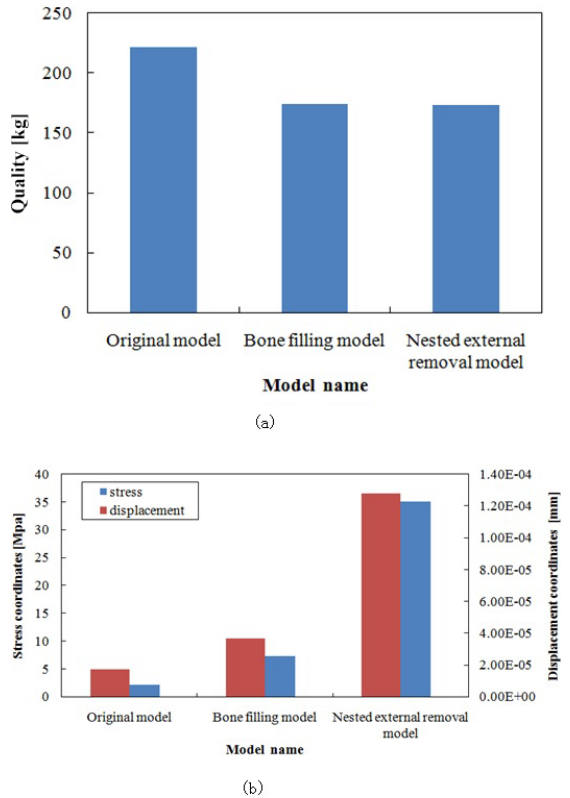
Figure 19. Comparison of the performance of the two optimized models: (a) quality comparison between the two optimized models and the original model; (b) stress–strain comparison between the two optimized models.